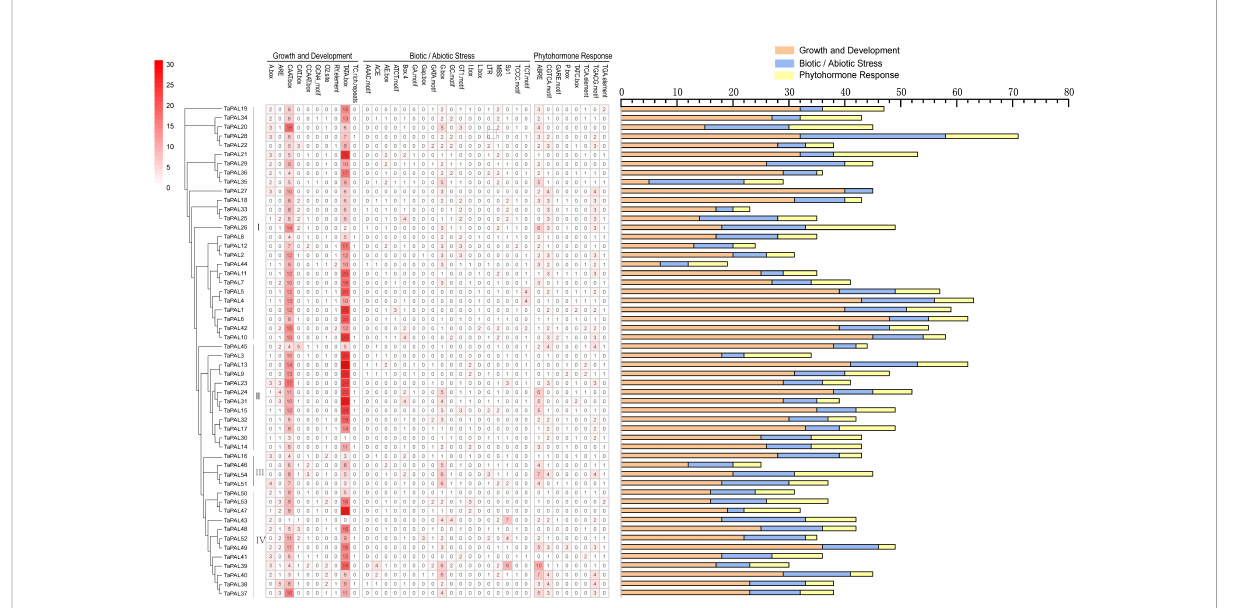
FIGURE 5 Analysis of cis-acting element numbers in TaPAL genes promoters. The different colors and numbers of the grid indicated the numbers of different promoter elements in these TaPAL genes. The different colored histogram represented the sum of the cis-acting elements in each category.